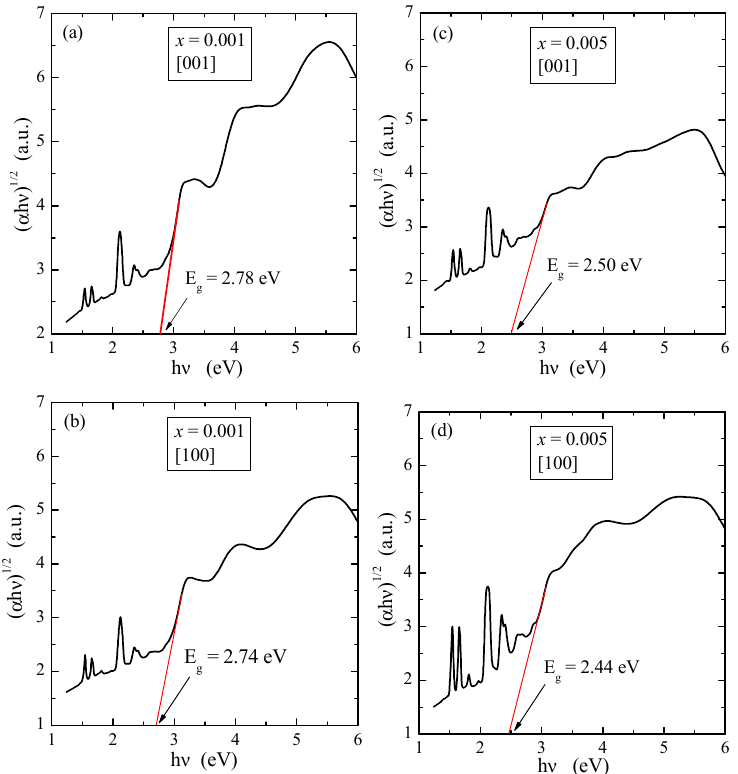
Figure 2. Plots of ( α h ν ) 1/2 vs. h ν of PNMWO single crystals: ( a ) x = 0.001 and [001], ( b ) x = 0.001 and [100], ( c ) x = 0.005 and [001], ( d ) x = 0.005 and [100].